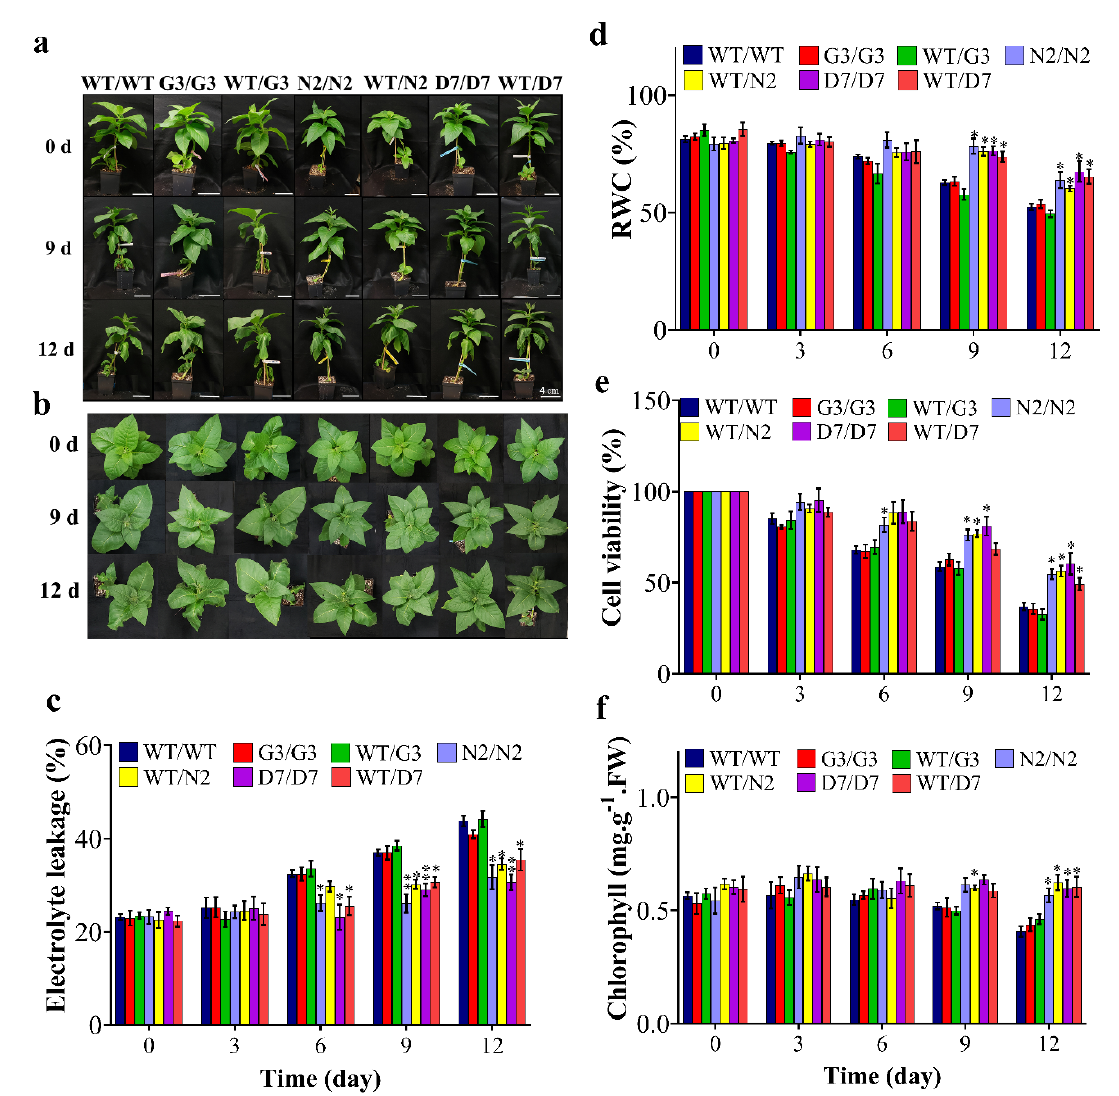
Figure 8. Physiological analysis of transgrafted tobacco plants under osmotic stress conditions. Comparison of wild-type homografted and transgrafted plants at 0, 3, 6, 9 and 12 days of exposing to PEG 10%; WT/WT, G3/G3, WT/G3, N2/N2, WT/N2, D7/D7 and WT/D7 are grafting combinations. ( a , b ) Tobacco transgrafted plants response after 0, 9 and 12 days of PEG treatment. ( c ) Electrolyte leakage, ( d ) relative water content (RWC), ( e ) cell viability, ( f ) chlorophyll content of homografts and transgrafts exposed to osmotic stress (10% PEG). The bars represent mean values ± SEM of three biological replicates (four plants each). Asterisk(s) indicate(s) significant differences between the means of wild type (WT/WT) and transgrafts of each treatment group at * p < 0.05, ** p < 0.01 according to Dunnett test.